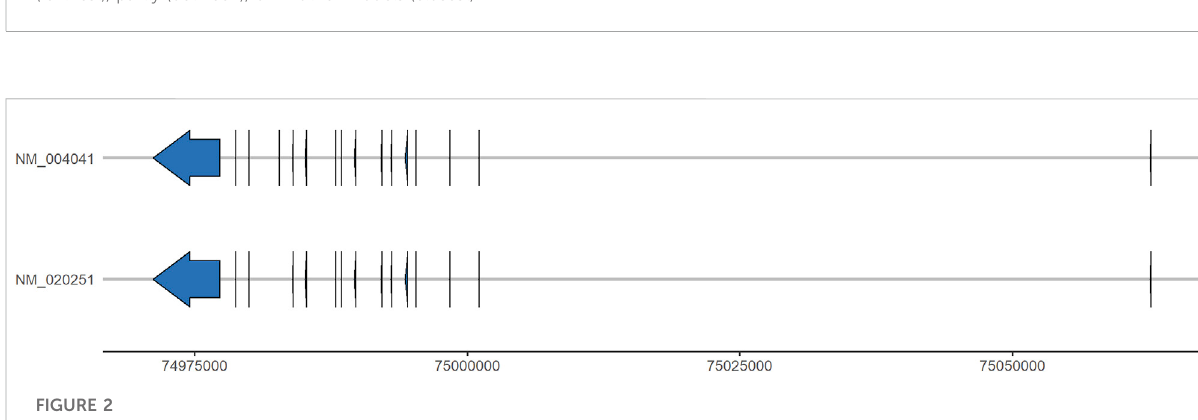
FIGURE 1 Timeline of β -arrestin 1 fi ndings in psychopharmacology. Findings pertaining to β -arrestin 1 and ARRB1 across time. Colored boxes denote broad β -arrestin 1 fi ndings (grey), β -arrestin 1 protein fi ndings in the context of depression and/or antidepressants (blue), or genetic associations in the context of neuropsychiatric disorders (orange). Distance from timeline denotes whether studies were conducted entirely in human participants (furthest), partly (between), or in other models (closest).